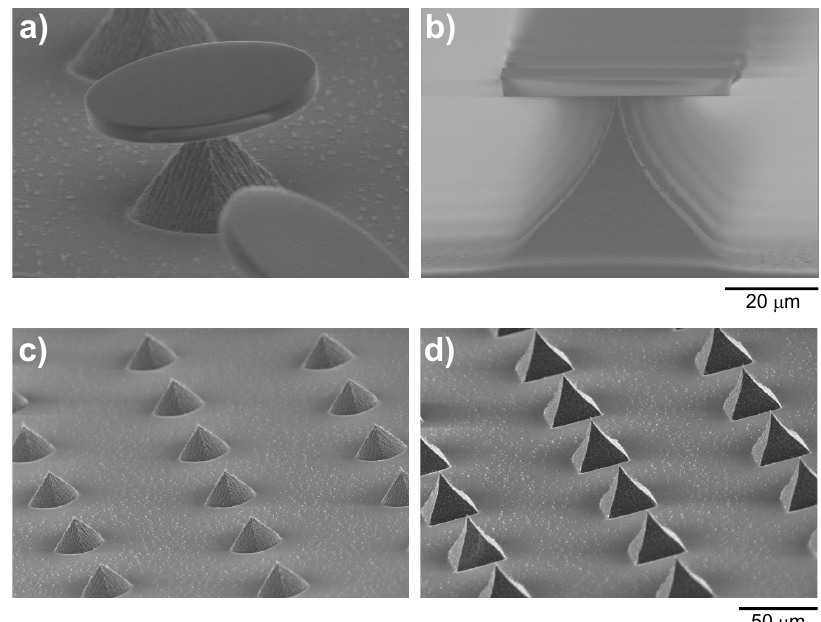
Figure 3. Scanning-electron-microscope (SEM) images of 3-dimensional Si absorbers before ( a ) cone-shaped and ( b ) pyramid-shaped; and after ( c ) cone-shaped and ( d ) pyramid-shaped the removal of S1830 photoresist.